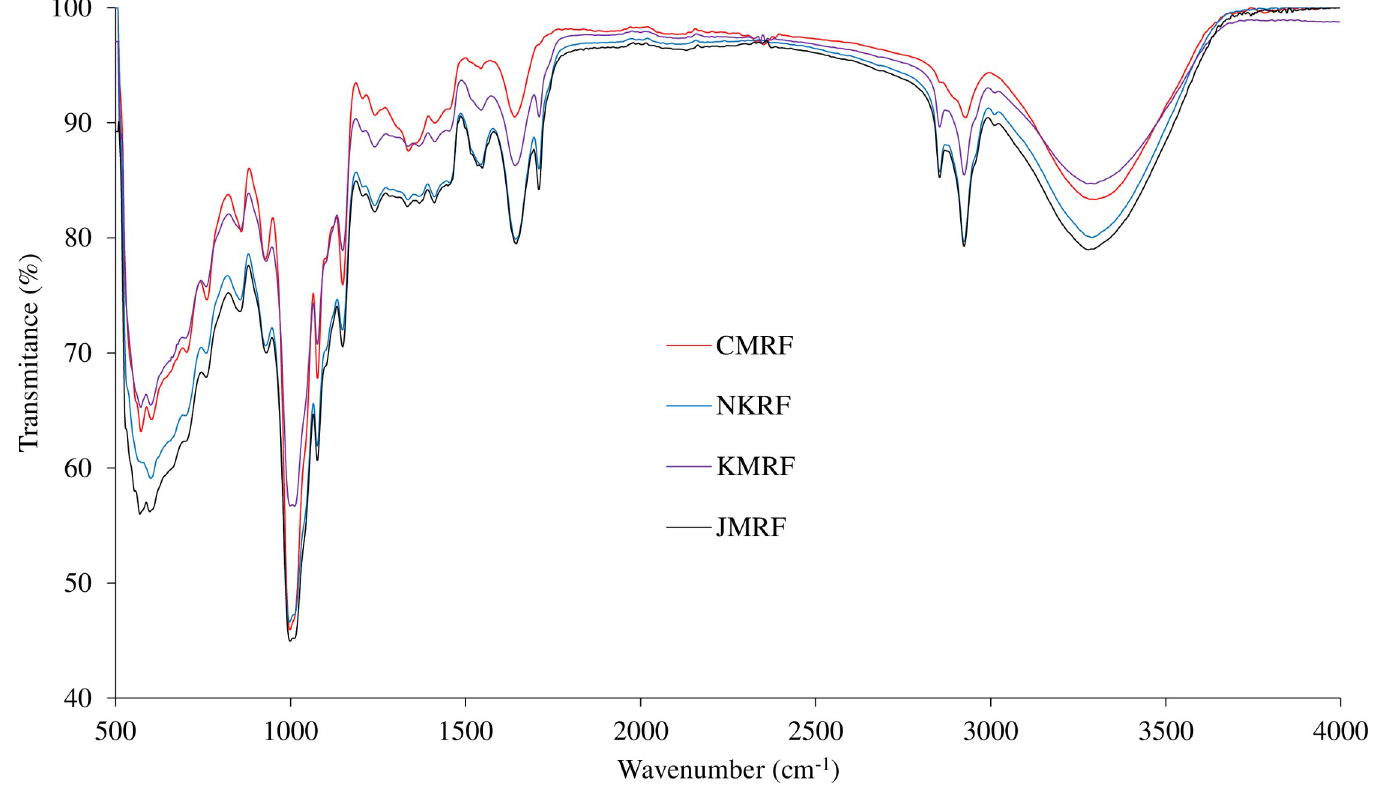
Fig 1. FTIR spectra of Thai indigenous organic brown rice flour, namely brown Khai Mod Rin rice flour (KMRF) and brown Noui Khuea rice flour (NKRF), in comparison with brown Jasmine rice flour (JMRF) and commercial rice flour (CMRF).